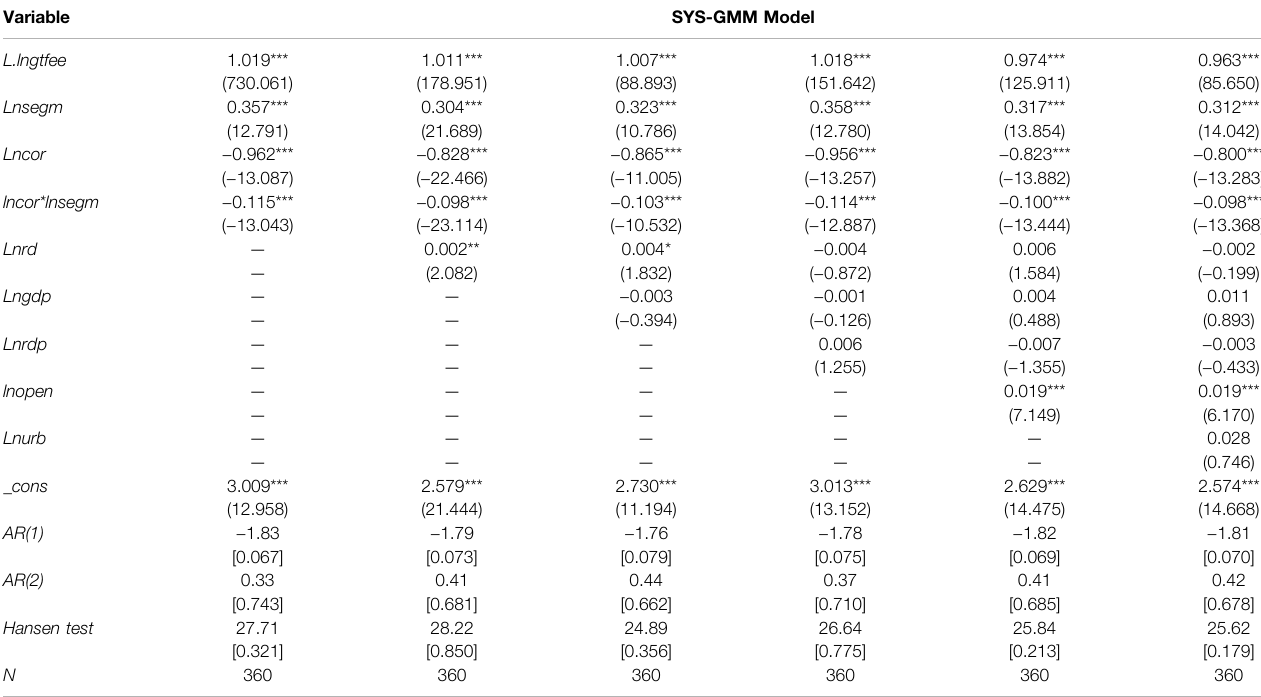
TABLE 4 | The estimated results of moderating